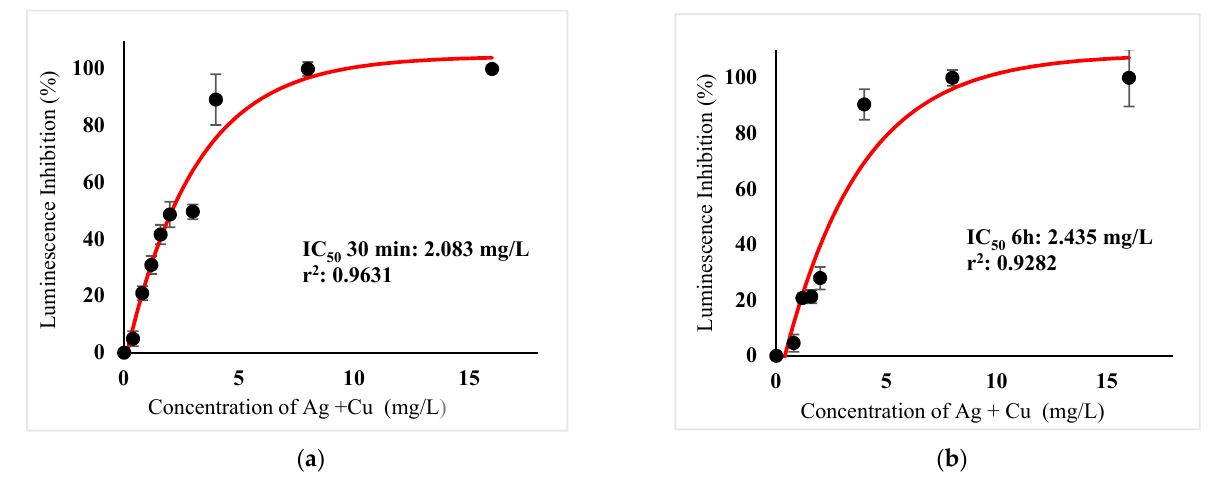
Figure 10. ( a ) Acute and ( b ) Chronic toxicity of mixture Ag + + Cu 2+ in the concentration ratio of 1:1 on luminescence inhibition of Photobacterium sp.NAA-MIE. Data represent mean ± SD, n = 3.